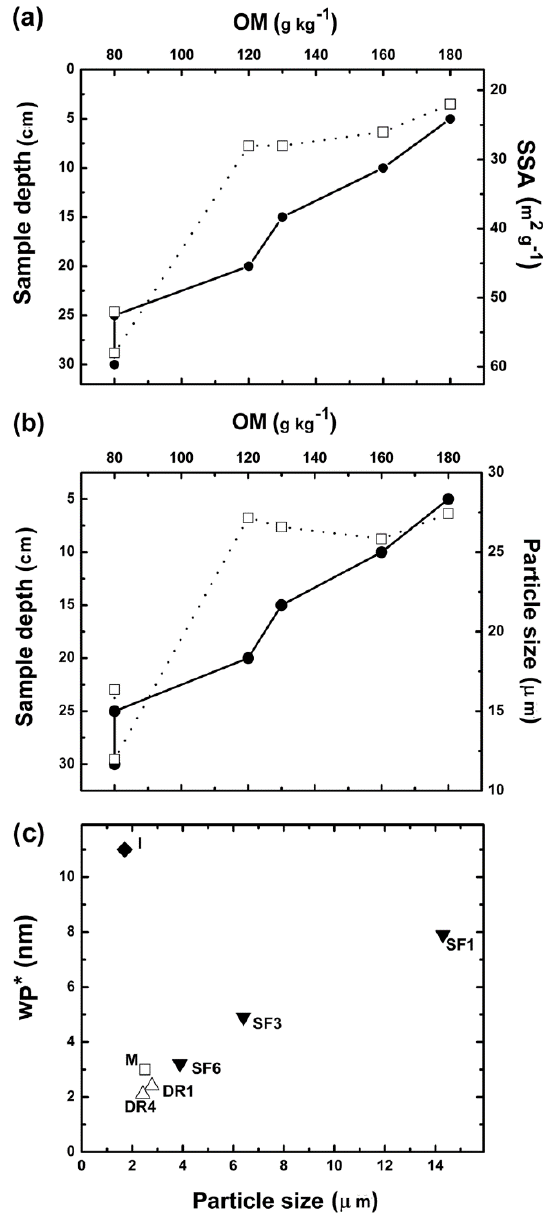
Figure 6. Depth distribution of (□) organic matter content (OM, g kg − 1 ) in relation with ( a ) specific surface area [(●) SSA, m 2 g −1 )] and ( b ) particle size [(●) μm], for SF bulk sediment and ( c ) relationship between particle size (μm) and the modal pore size (w P , nm) for the clay fractions of DR (DR1: 0–5 cm and DR4: 15–20 cm) and SF (SF1: 0–5 cm, SF3: 10–15 cm, and SF6: 25–30 cm). The reference clays are indicated as ( ) illite (I) and (□) montmorillonite (M).